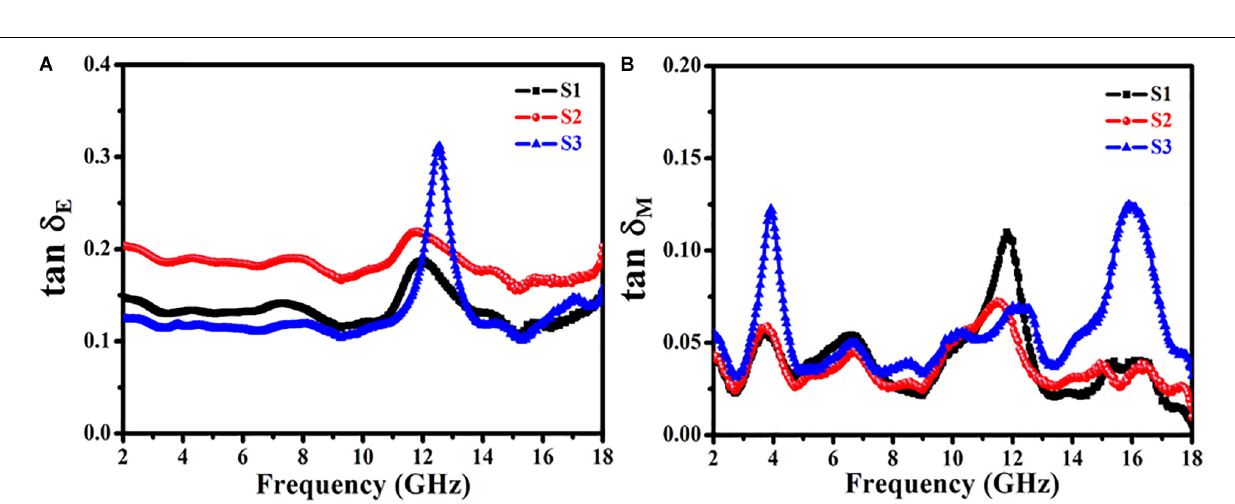
Frontiers in Materials |